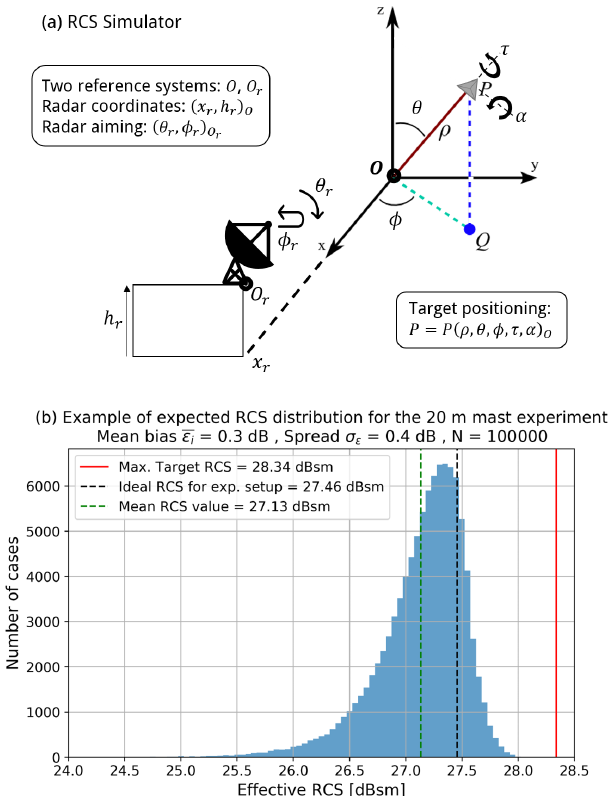
Figure 9. (a) Diagram of the RCS simulator illustrating its degrees of freedom. (b) Example of an effective RCS distribution obtained after 100000 simulations with the uncertainty set specified in the text. The simulations are based on our 20m mast setup. Bias is cal- culated by subtracting the ideal RCS from the mean RCS value. The example illustrates how the effective RCS will be, statistically, lower than the result expected from an ideally aligned